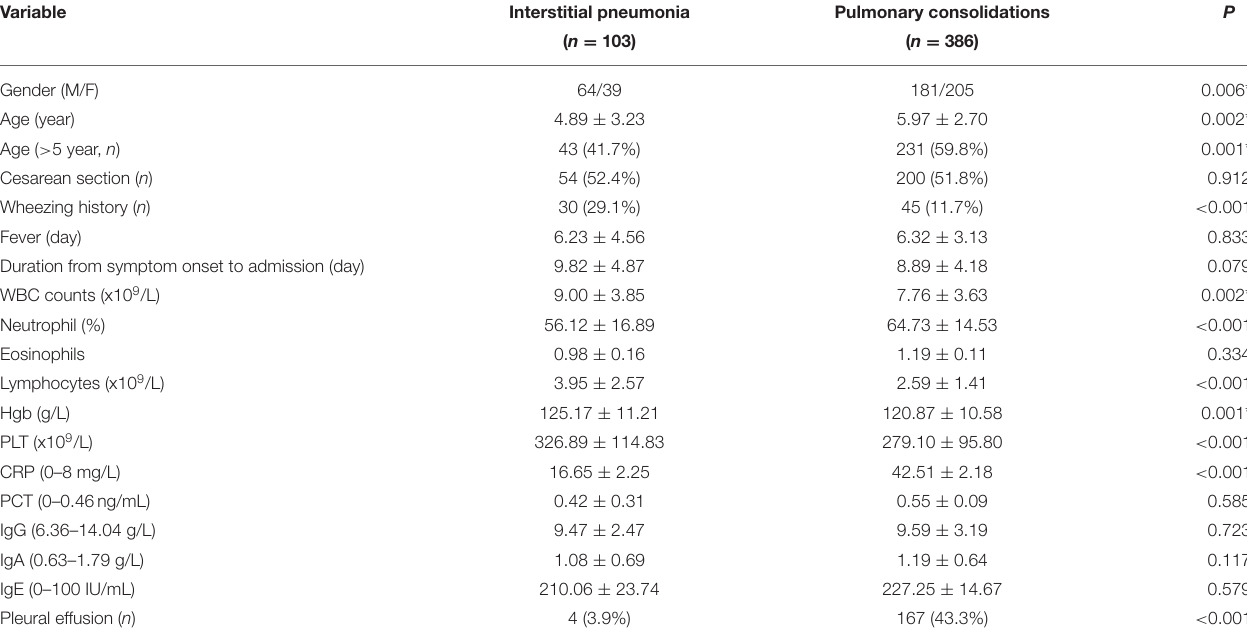
TABLE 1 | Clinical characteristics and laboratory findings between IP and PC.